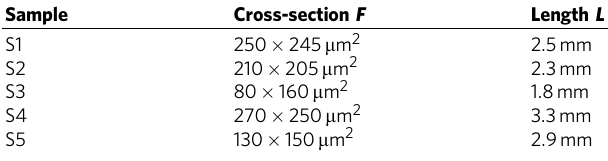
Fig. 1a. The prepared samples each have cross-section F and length L as shown in Table 1. S4 and S5 were obtained by cutting a single crystal into two pieces,